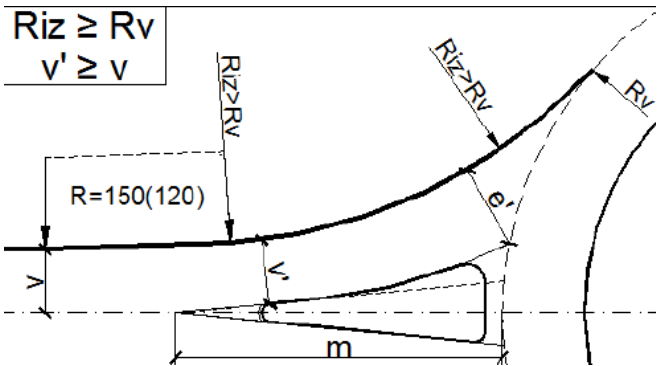
Figure 20. Exit design according to [4]: “v’” is the approach lane width, “m” is the splitter island length, “R v ” is the roundabout outer radius, and “R ul ” is the entry